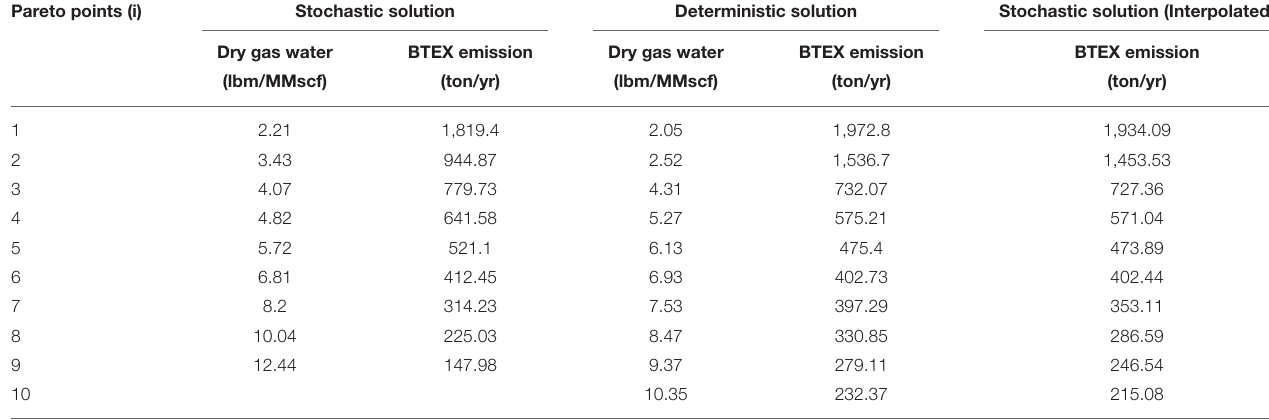
TABLE 6 | Interpolated values of BTEX emission. Pareto points